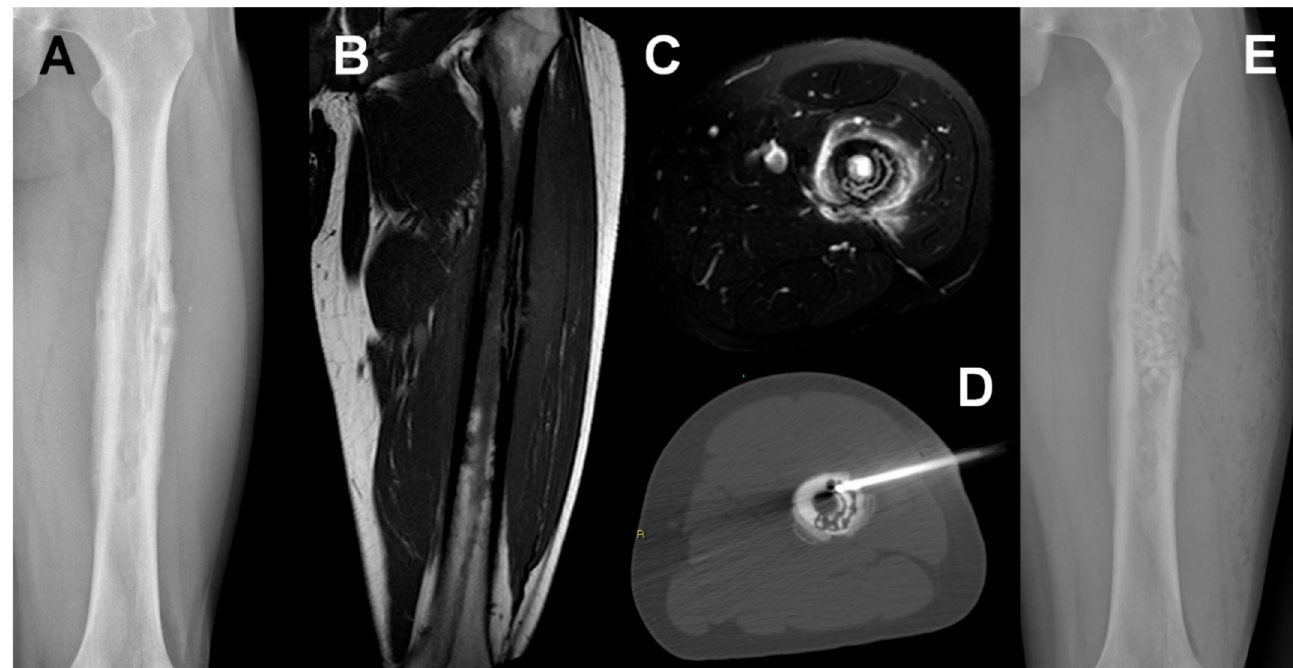
Figure 1. Staphylococcus aureus Osteomyelitis in a 20-year-old man. A conventional radiograph ( A ). MRI coronal T1w ( B ) and axial T2w fat-saturated ( C ) show a permeative lesion of the left femoral shaft. CT-guided biopsy permitted to identify the responsible microorganism ( D ). Conventional radiograph after surgical treatment showed antibiotic microspheres placed into the bone ( E ).